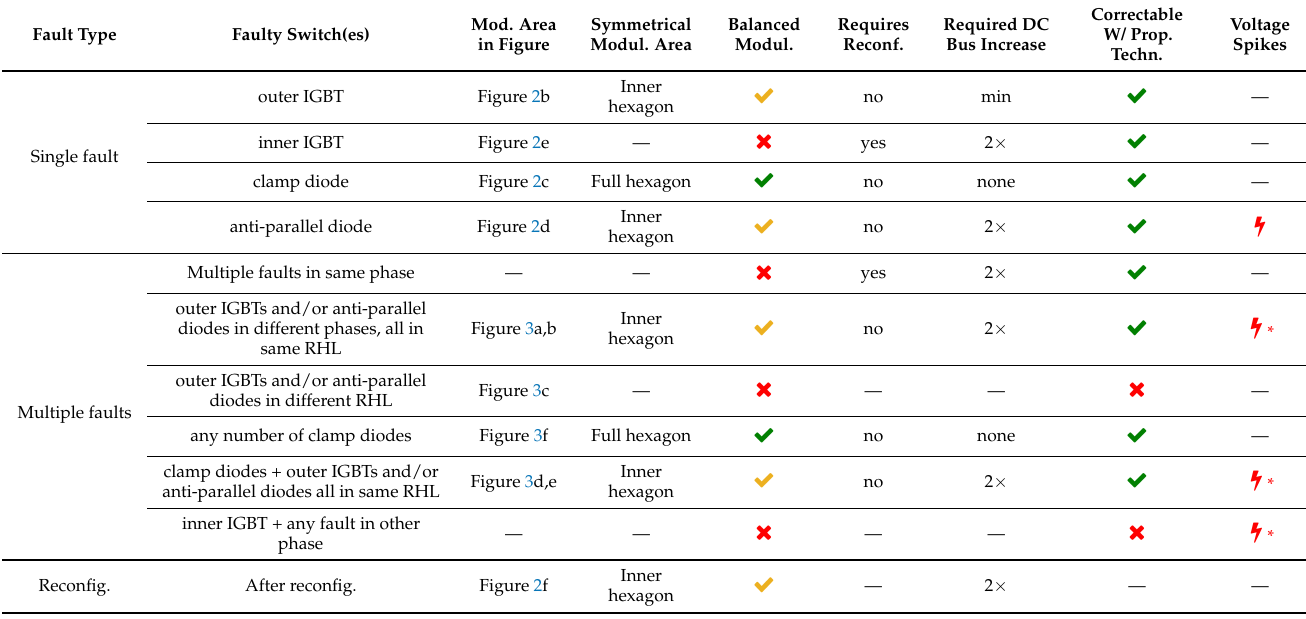
Table 1. Consequences of different 3NLC faults and their correctability with the proposed solution. Mod. Area in